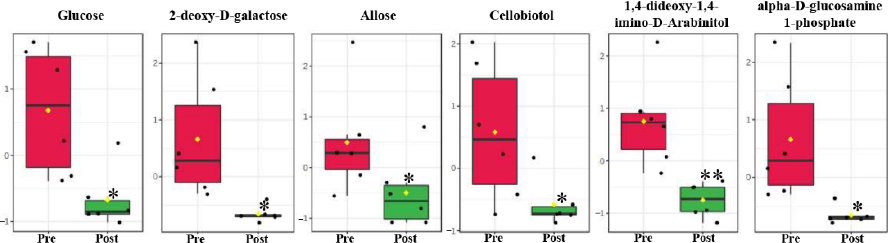
Figure 2. Changed carbohydrates in serum between pre- and post-pubertal molting groups. Values are means and standard deviations. Pre, pre-pubertal molt group. Post, post-pubertal molt group. Asterisks * and ** denote significant difference at the p < 0.05 and p < 0.01 levels, respectively.